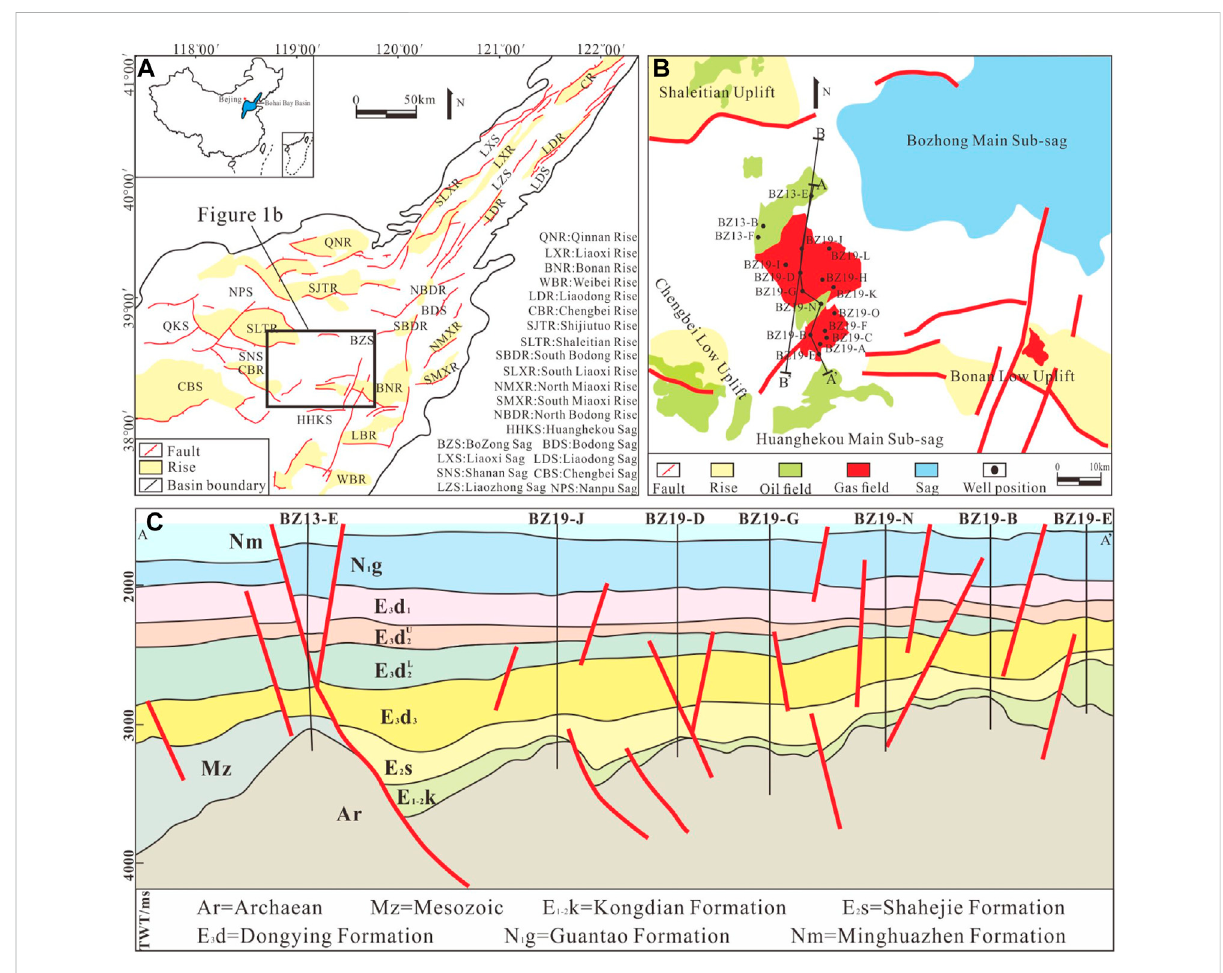
FIGURE 1 Geological features of the Bohai Bay Basin. (A) Location of the study area in the Bohai Bay Basin (modi fi ed after Ye et al., 2020); (B) Simpli fi ed structural map of theBozhong Sag (modi fi ed afterXue & Li, 2018); (C) Typical geological section through BZ19-6 and adjacent areas (locationof the section see Figure